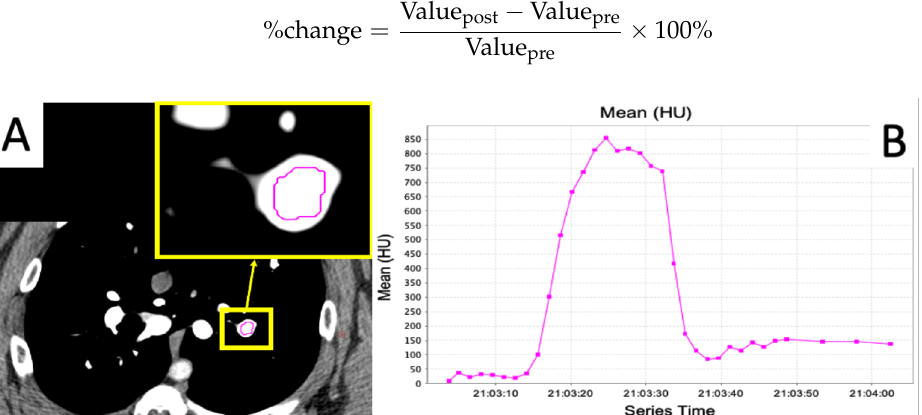
Figure 2. Example of a curve showing the flow of contrast into and out of a vessel. ( A ) Example slice in a frame of the scan showing the placement of an ROI in a vessel. ( B ) Average Hounsfield Unit (HU) value inside the ROI over the frames of the scan. Increasing HU represents contrast flow into the vessel, and decreasing HU represents contrast flow out of the vessel.